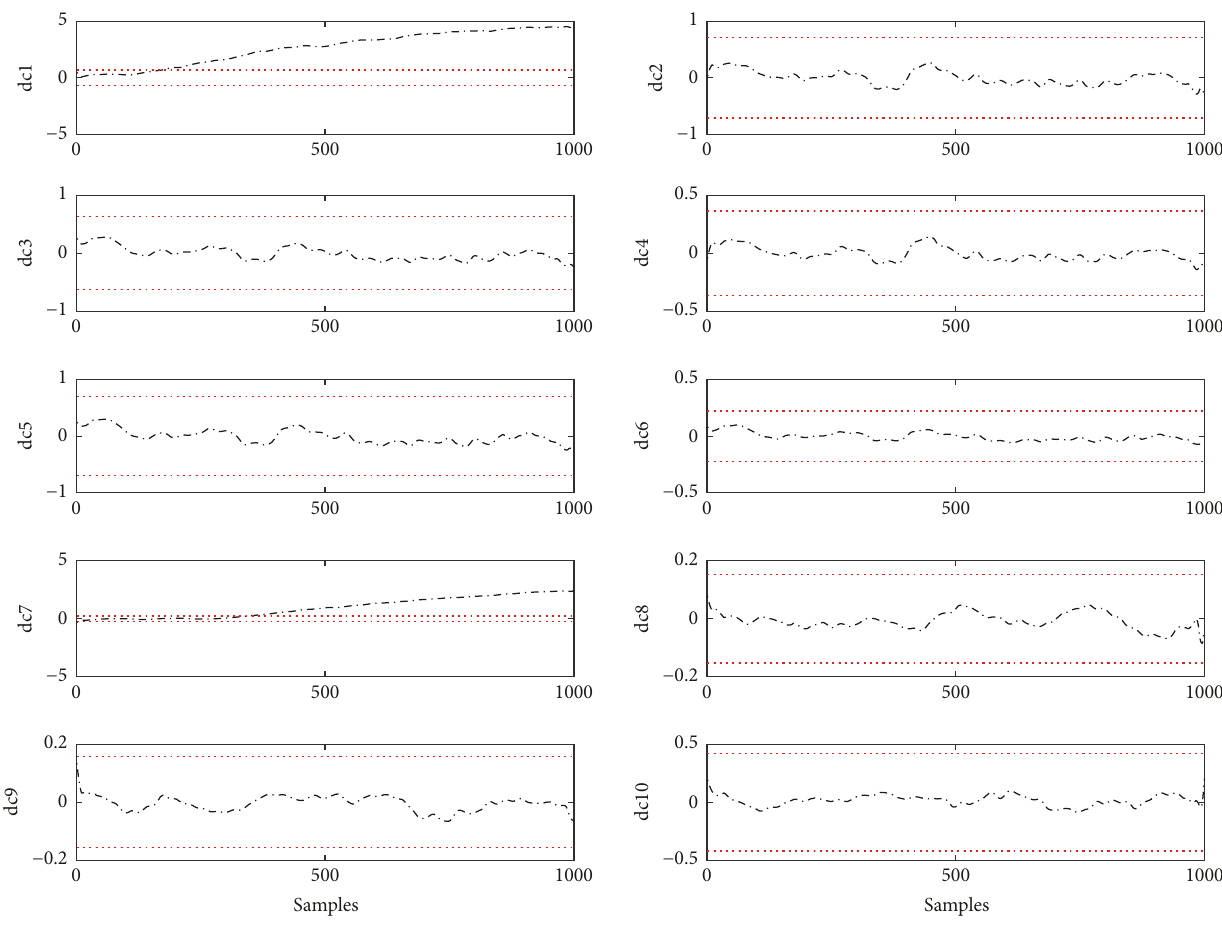
Figure 9: Online early fault diagnosis based on DCA.